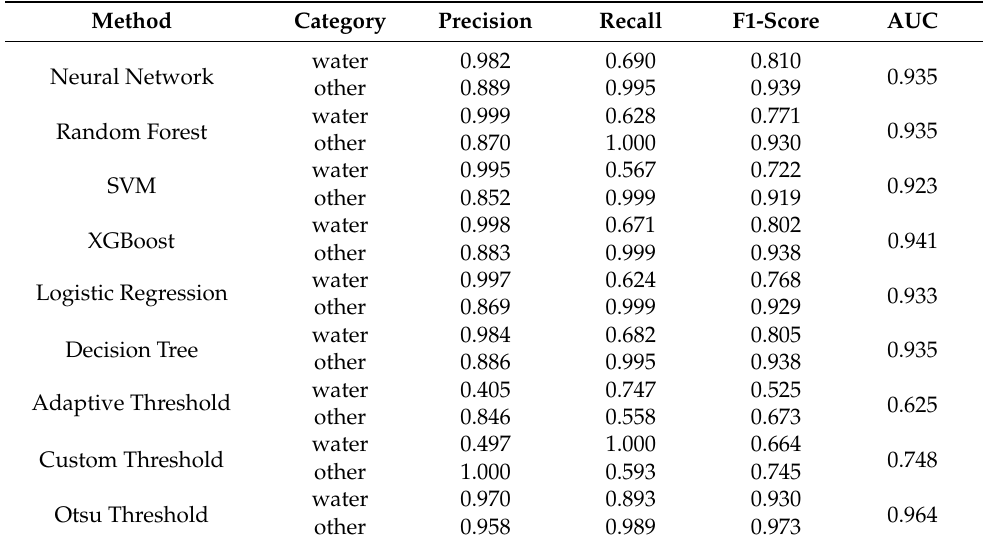
Table A4. Statistics of various indexes of each algorithm in Area3 on October 20.